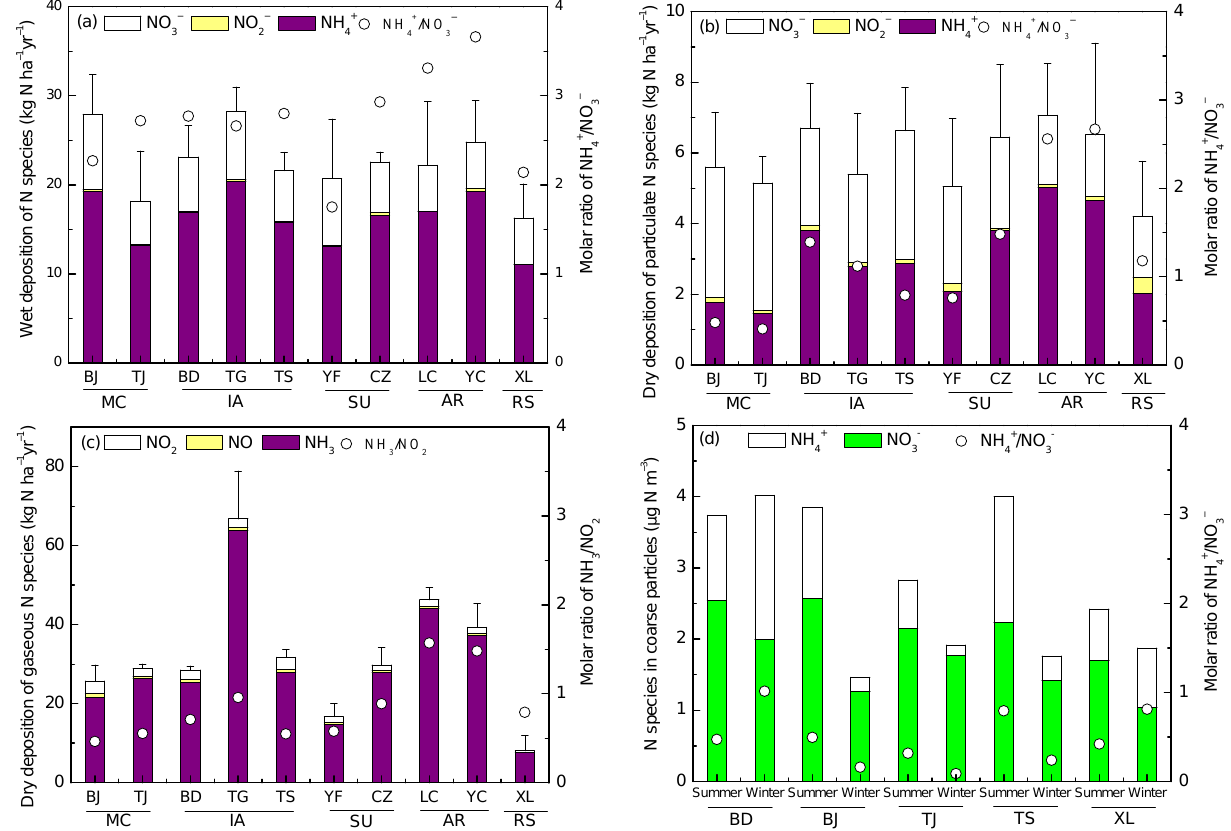
Fig. 2. Atmospheric deposition flux of nitrogen species at the ten selected sites in Northern China. The data shown are means of three-year observations, with the error bars denoting standard deviation. MC, IA, SU, AR and RS denote urban, industrial, suburban, agricultural and rural sites, respectively. The definition of the site codes is found in the caption of Fig. 1. The molar ratios of NH + to NO − in precipitation 4 3 (a) and dry-deposited particles (b) were calculated using flux data, whereas the molar ratio of gaseous NH 3 to NO 2 was calculated using concentration data (c) . The concentrations of NH + and NO − in coarse particles with a diameter larger than 2.1µm (d) are derived from our 4 3 previous size-resolved compositional analysis performed for particles between 0.1 and 100µm diameter over bi-weekly intervals during the winter (from December 2009 to February 2010) and summer (from June to August 2010) at the five sites simultaneously (Sun, 2011). The daily aerosol samples were collected on Teflon filters with an 81mm diameter using a nine-stage cascade impactor (Anderson Series 20-800, USA) at a flow rate of 28.3lmin − 1 . Therefore, in total, during the period of study, 12 sampling campaigns were carried out at each site. The pre-treatment and analysis of the samples were similar to the PUF filters described in Sect.